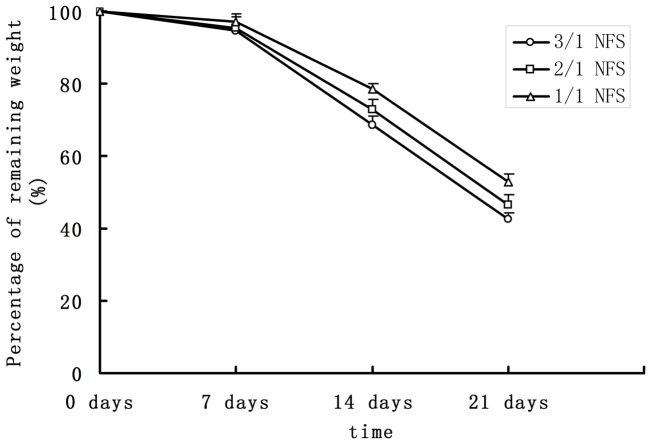
Degradation curve of different NFS in vitro.As mentioned in the introduction paragraph, the PLLA degrades faster than PCL. Thus, the degradation curve of 3/1 NFS was below the curves of 2/1 and 1/1 NFS.